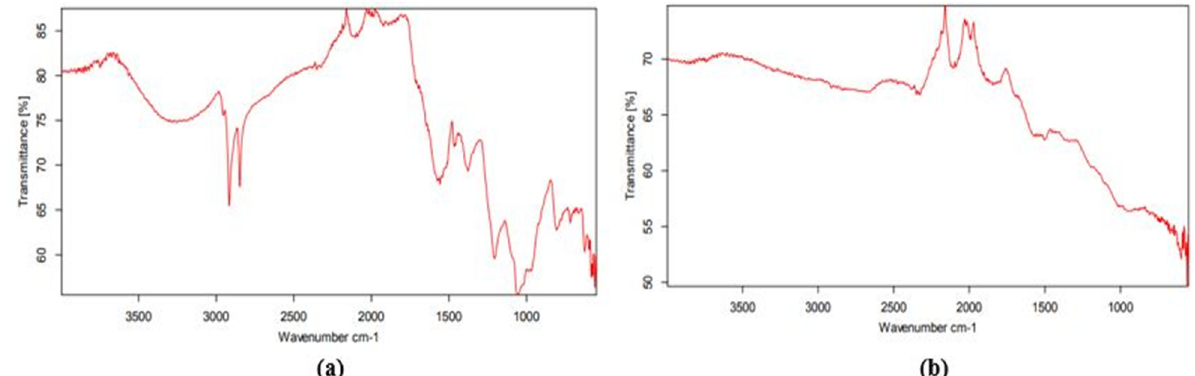
Figure 4. FTIR spectrum of silver nanoparticles synthesized using the leaf extract of Acer oblongifolium and AgNO 3: ( a ) 25 mM precursor solution of AgNO 3 , ( b ) 1 M precursor solution of AgNO 3.